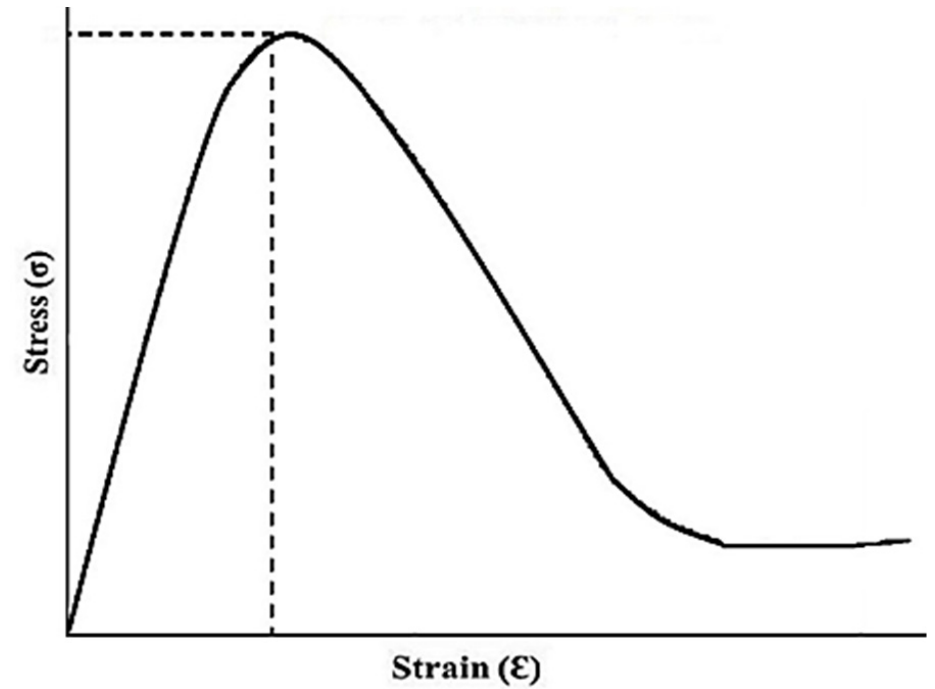
Figure 9. Tensile stress–strain curve.